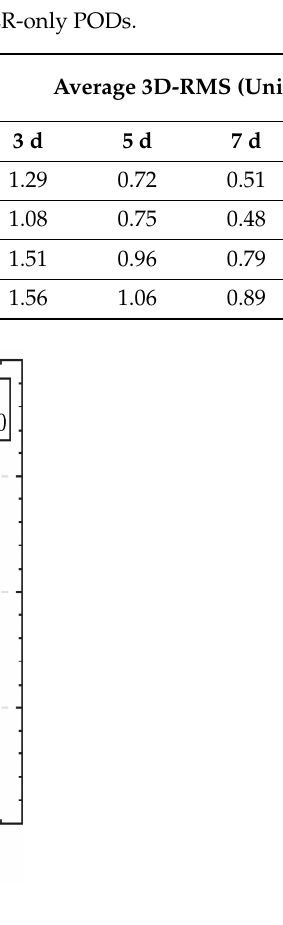
Figure 5. The overall average 3D-RMS of SLR-only PODs.